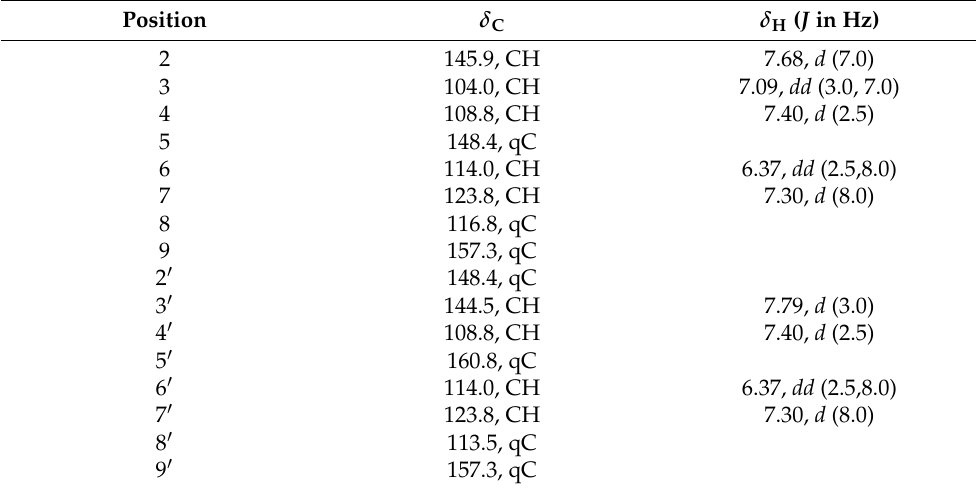
Table 2. DEPT-Q (400 MHz) and 1 H-NMR (100 MHz) data of compound 28 in CDCL 3 ; carbon multiplicities were figured out by the DEPT-Q experiments.